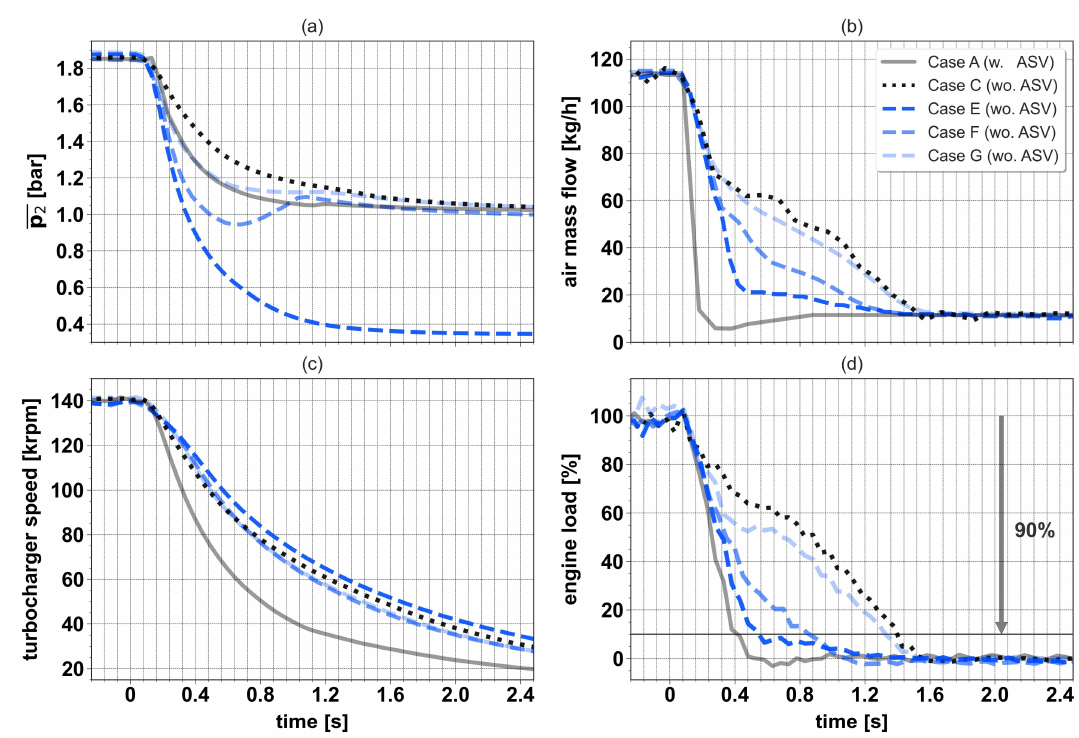
Figure 9. Time evolution of compressor outlet pressure ( a ), air mass flow at filter outlet ( b ), tur- bocharger speed ( c ), and engine load ( d ) for Cases A, C, E, F, and